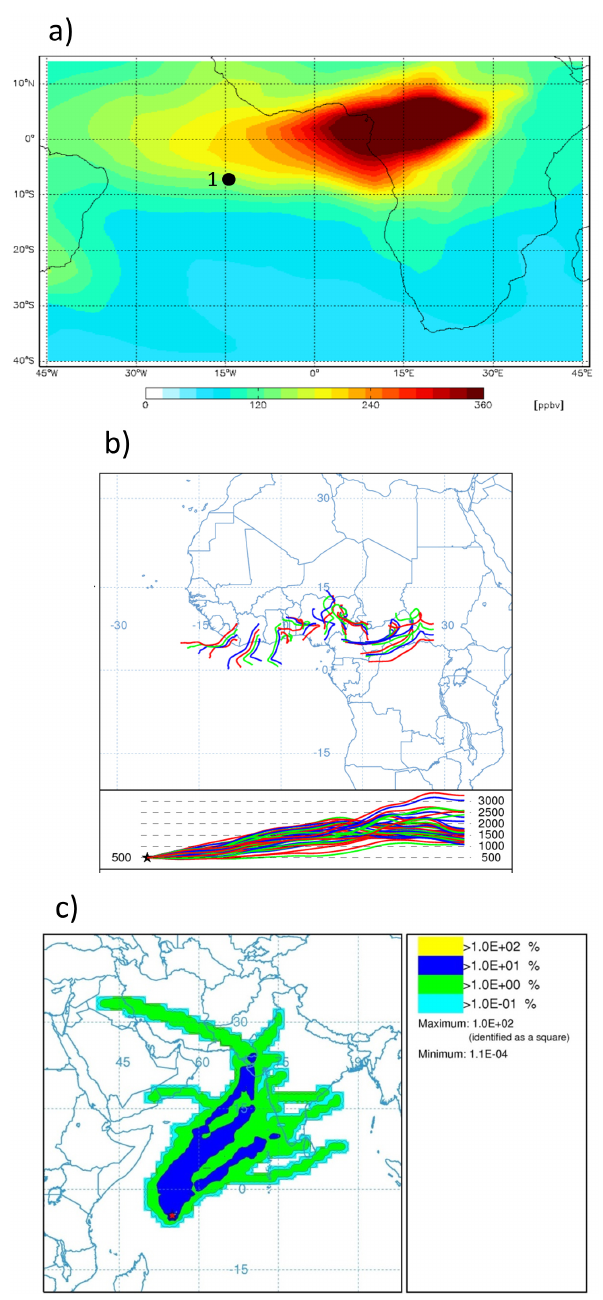
Figure 3. (a) Monthly averaged CO concentrations (ppb) computed by GEOS-Chem at 704hPa in January 2005. The station location (refer to Fig. 1 for station number) is also shown. (b) A plot of 3.5- day forward-trajectory matrix launched on 20 January 2005 from northern Africa. (c) A monthly back-trajectory frequency (%) plot in January 2004 when the measured CO is high at Mahé. The trajec- tory frequency plot includes 10-day backward trajectories launched everyday for a month from Mahé. The frequency plots in other years when the measured CO is high are included in the